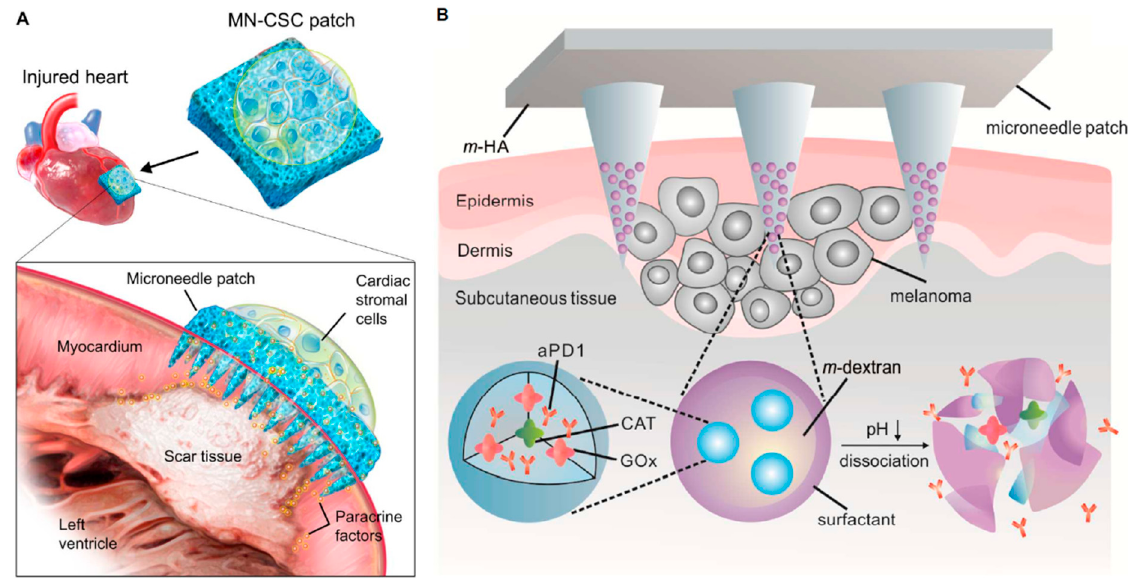
Figure 14. ( A ) Schematic illustrating the overall configuration used for measuring therapeutic benefits of infarcted heart microsomal cells. This groundbreaking work paves the way for the potential production for organ recovery and reconstruction of cell integrated MNs, reproduced with permission from [400], American Association for the Advancement of Science, 2018. ( B ) MN patch-assisted PD1 scheme for the prevention of skin cancer. Innovative projects pave the way for the potential creation of cancer immunotherapy focused on MNs, reproduced with permission from [401], American Chemical Society, 2016.